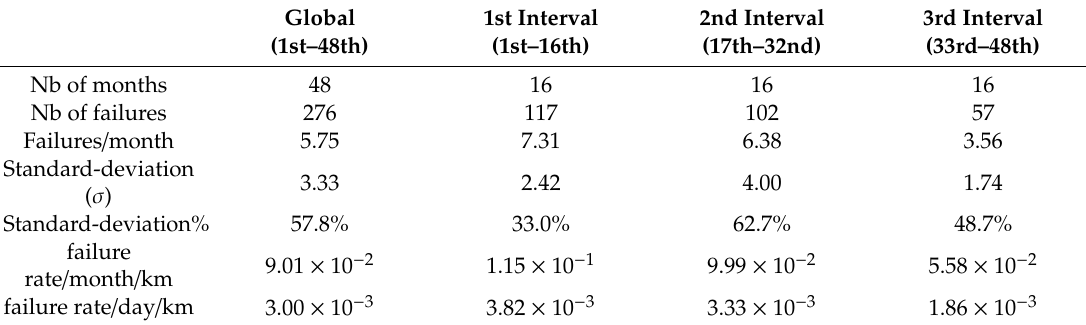
Figure 8. Histogram of failures per month and the estimated mean values per interval. Table 1. Failures occurrence statistical data: global and by